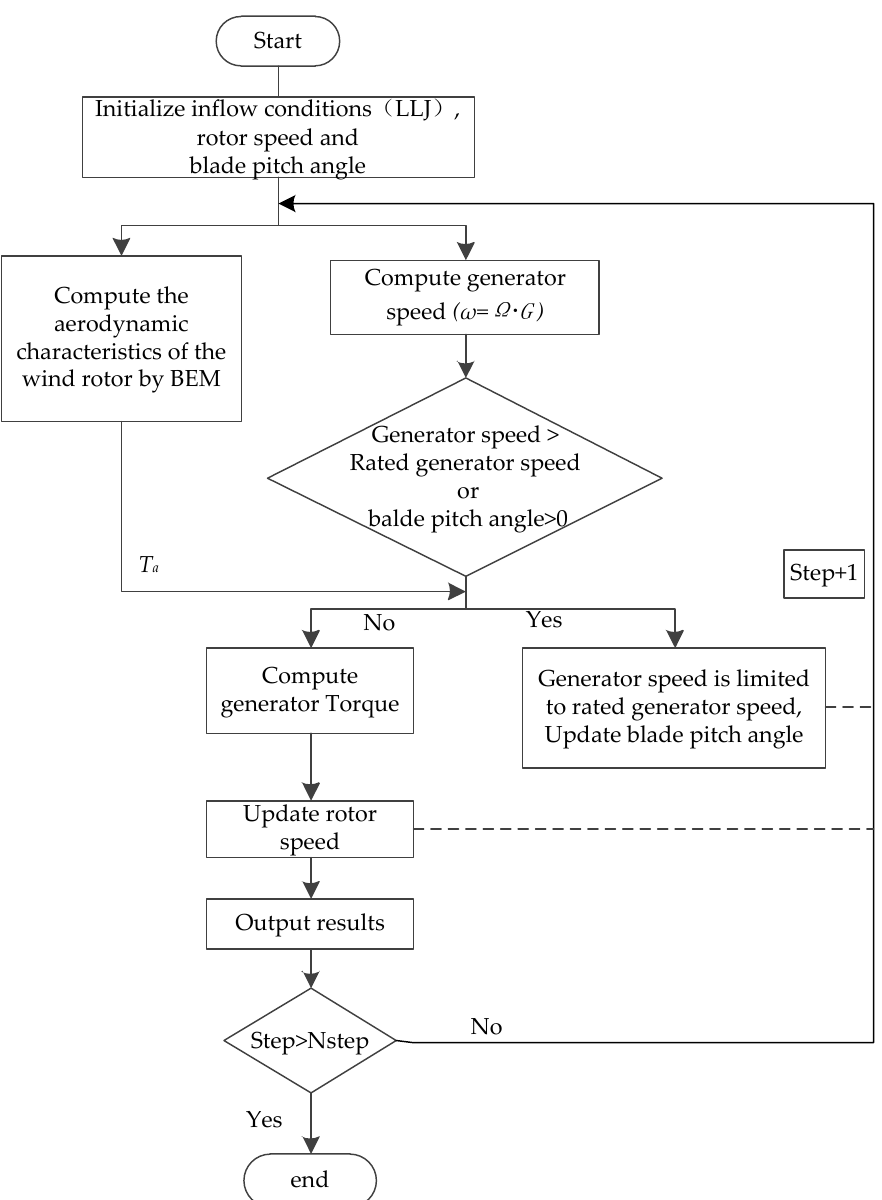
Figure 4. Flow chart of aerodynamics–controller interaction method.